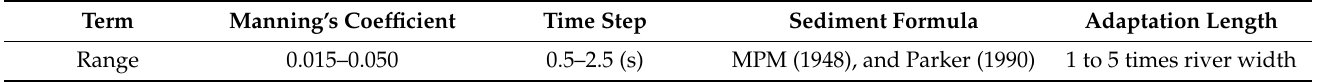
Table 1. Parameter range